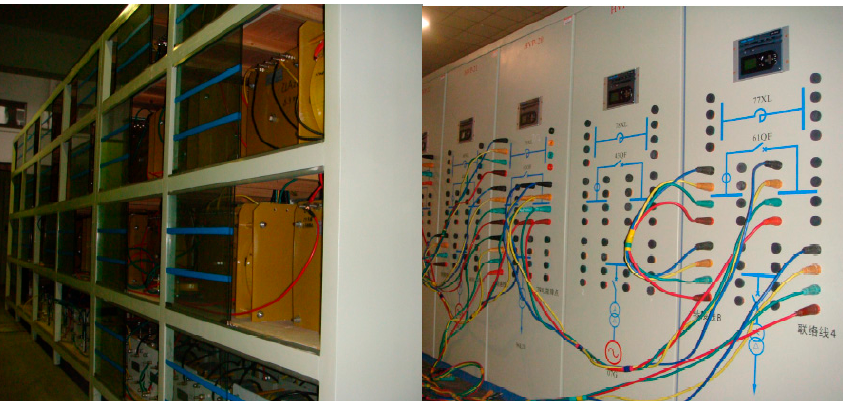
Figure 3. Traditional π -shape physical model of the three-phase transmission line.